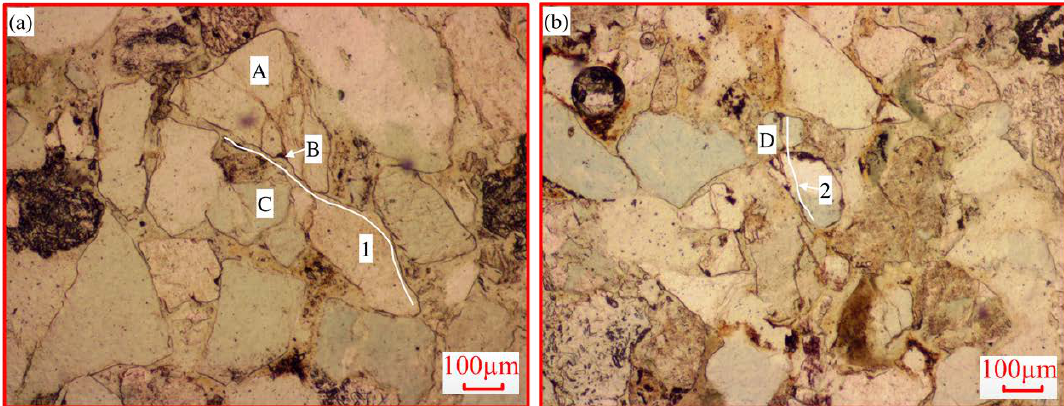
Figure 15. Transgranular cracks along the intergranular cracks in the sample. ( a ) Grain A is crushed at point B along the inter-granular crack 1, the white line marked as 1 in the white square, at the top of grain C, and ( b ) grain D is punctured into two parts by the intergranular crack 2, the white line marked as 2 in the white square.